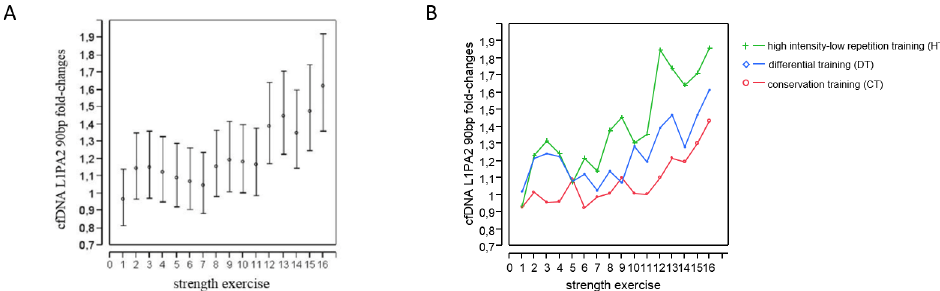
Fig 1. Significant increasesof cfDNA levels after the 12 th exercisecompared to baseline levels. (A) Fold changesof cfDNA concentrations after each strength exercise (1–16) comparedto baselinelevels across all types of training(CT, HT and DT) and at both monitoringpoints in time (1 st and 12 th day). Means (circles) and 95% CIs are presented. (B) Fold changes of cfDNA concentrations after each strength exercise (1–16) comparedto baselinelevels shown separately for CT, HT and DT